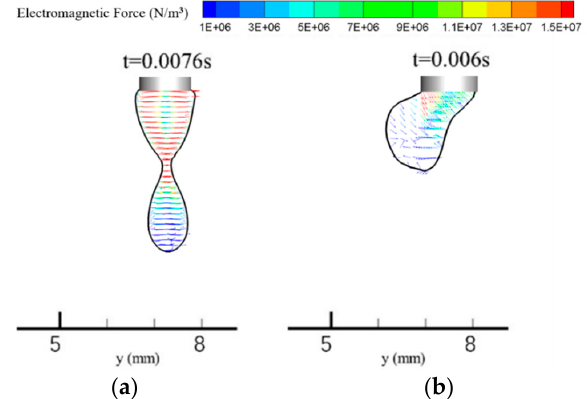
Figure 9. The electromagnetic force distribution in the droplet: ( a ) MIG; ( b )